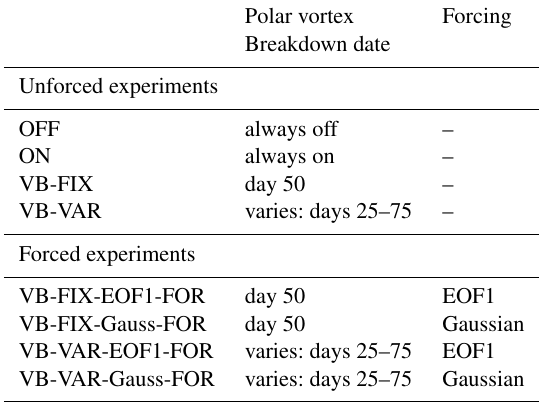
Table 1. Barotropic experiment setups. All unforced experiments share the same basic setup described in the text (identical to BARO in Barnes and Thompson, 2014) and only differ in the influence of the stratospheric polar vortex, which is parameterised here as a torque given by Eq. (5). OFF and ON are control experiments, mimicking an absent or active polar vortex, respectively. VB-FIX and VB-VAR mimic a vortex breakdown respectively without and with interannual variability. The latter two setups are used to per- form forced experiments, applying a Gaussian forcing centred at 55 ◦ S with a standard deviation of 5 ◦ and a maximum amplitude of 0.5ms − 1 d − 1 (suffix Gauss-FOR), or an EOF1-like forcing